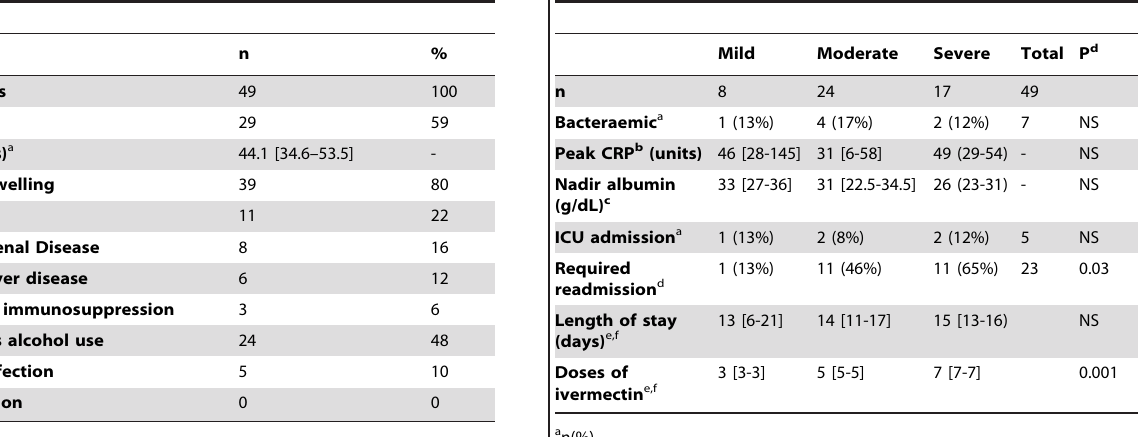
Table 1. Demographics and comorbidities. Table 2. Grading scale, disease severity, and